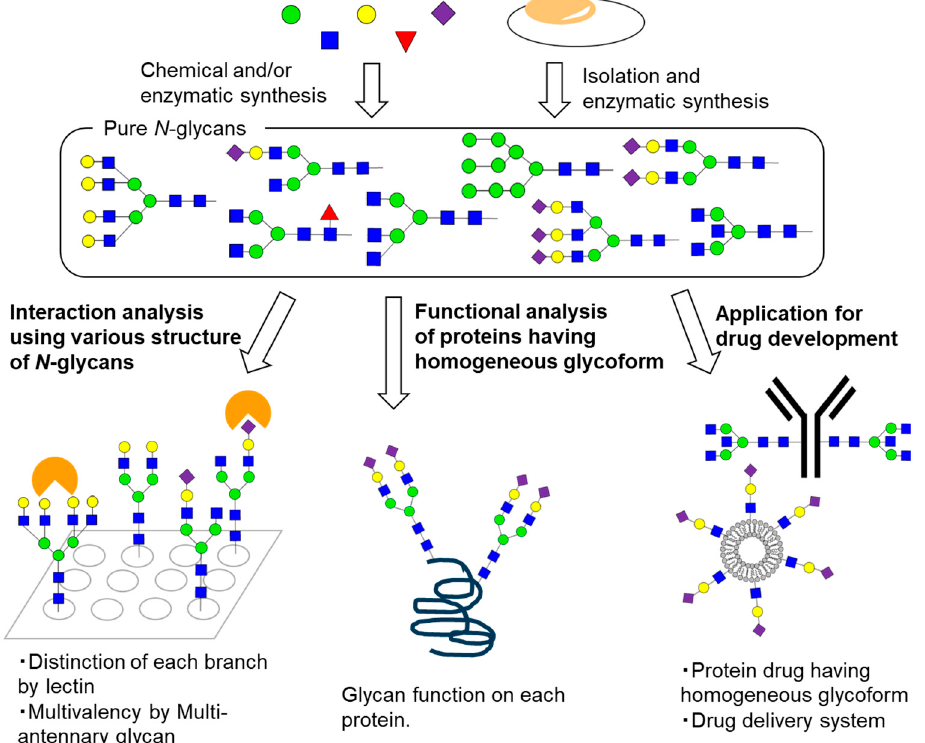
Figure 2. The chemical biology study of homogeneous N -glycans. Chemical synthesis, enzymatic synthesis, and isolation of diverse, pure N -glycans enable their functional analysis at the molecular level. Interaction analysis using various N -glycans revealed the significance of complex N -glycan structures—for example, distinction of each branch and multivalent interaction in lectin recognition. Functional analysis using proteins with homogeneous glycoforms clarifies glycan function on each protein. Application of N -glycans for drug development is also investigated.